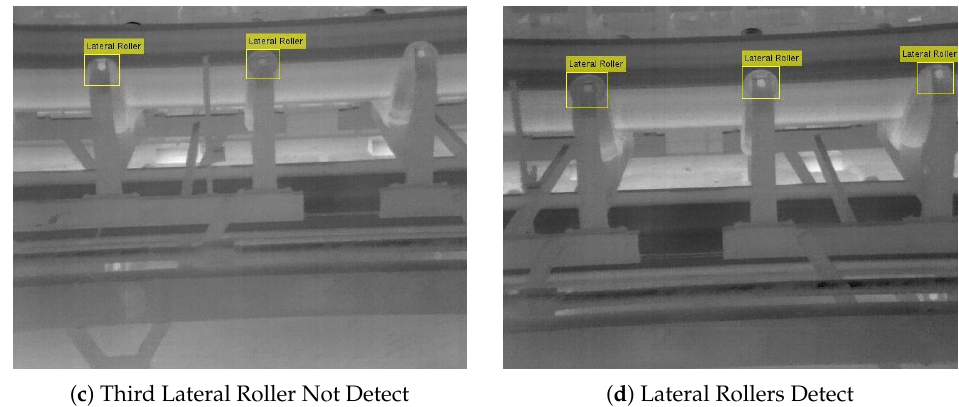
Figure 9. Training for Object Recognition: ( a ) Different regions of the rollers selected. ( b ) Left Central Rollers found using the trained detector. ( c ) Third Lateral Roller not found using the trained detector. ( d ) The Third Lateral Roller from Figure 9d, which is now the central lateral roller was